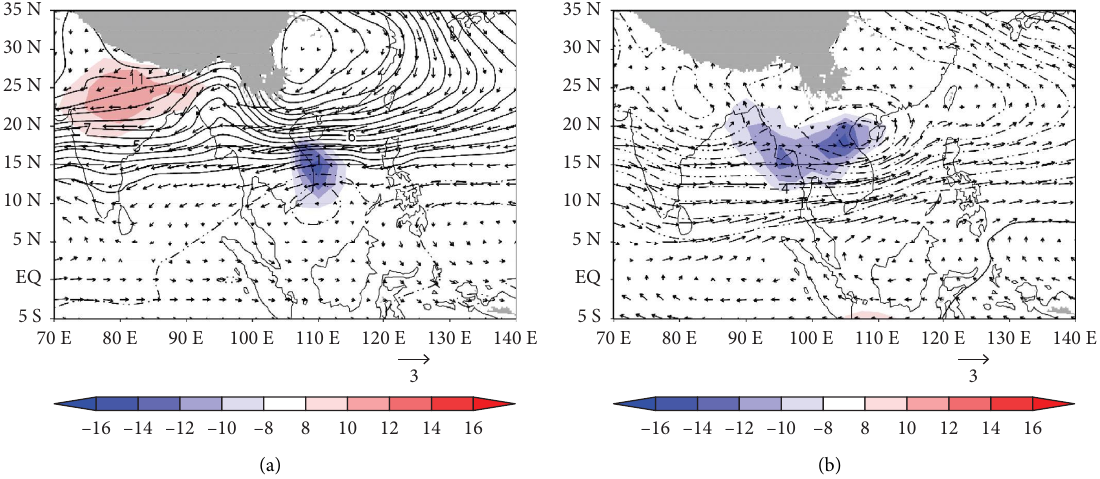
Figure 8: OLR ( shaded , Wm − 2 ), 850hPa wind ( vector , ms − 1 ) and geopotential height ( contour , m) anomalies regressed on the PC1 (a) and PC2 (b). (a) OLR,wind, hgt regreseed on PC1. (b) OLR,wind, hgt regressed on